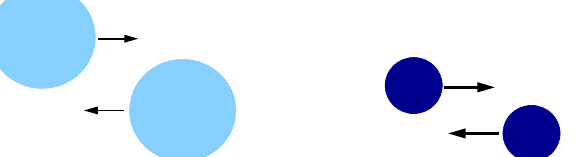
Figure 2. Schematic view of proton-proton collisions for a broader ( left ) or narrower ( right ) proton transverse